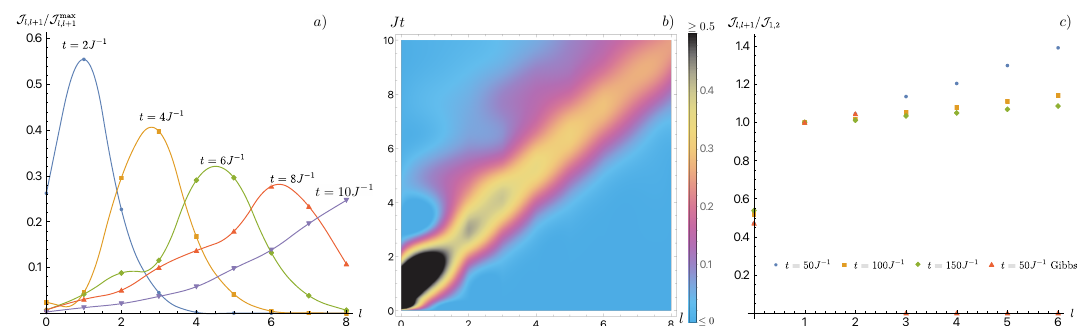
Figure 5: Time-evolution of information in the transverse- and longitudinal-field quantum Ising Hamiltonian starting from the initial state (36) that is the product state of maximally mixed states except at a single site where the spin points in the positive x -direction. a) The total information-current in units of the maximum total ≈ 0.45 at several different times (before the dynamics max information current l → l + 1 J is dominated by diffusion). b) The total information-current in units of the max- ≈ 0.45 for a continuum of times. c) The max imum total information current l → l + 1 J ≈ 15 × 10 − 5 for information-currents at late times in units of → 2 , which equals J 1 t = 50, ≈ 4.2 × 10 − 5 for t = 100 and ≈ 2.1 × 10 − 5 for t = 150. As a comparison, the current in a 3-local Gibbs state, with the same local density marices, at t = 50 J − 1 , is shown. The Gibbs state underestimates the current by several orders of magnitude; For example, at t = 50 J − 1 the current is underestimated by a factor of 1.3 × 10 4 , J 3,4 it continues to decay, and is underestimated by a factor of 1.4 × 10 12 . In a) and J 7,8 b) the values at non-integer l , given by third order spline interpolation, are added as a guide to the